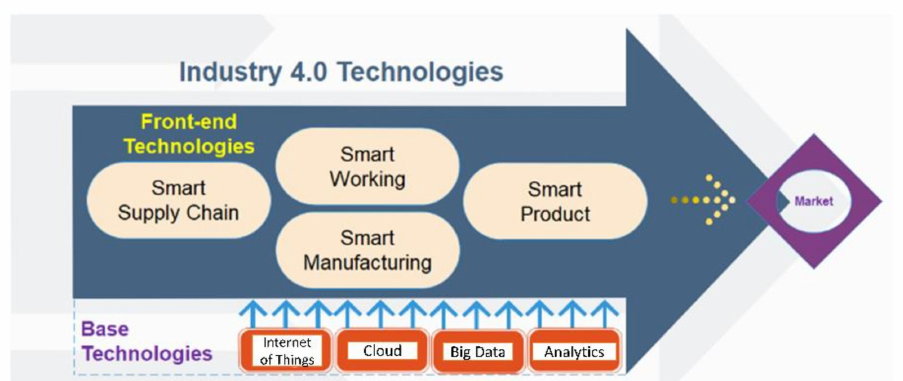
Figure 1. Theoretical framework of Industry 4.0 technologies [15]. Reproduced with permission from Ref. [15]. Copyright (2019), International Journal of Production